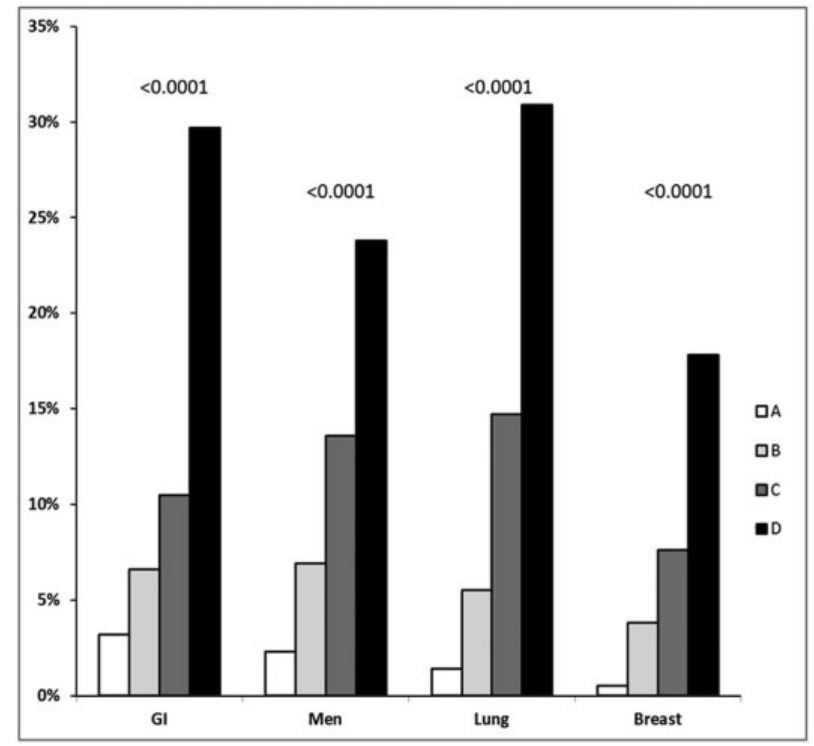
Fig. 4 Early mortality by groups at risk in the validation cohort of patients with cancer-associated thrombosis. ( A ) No metastatic disease and no elevated WBC count. ( B ) Metastatic disease without PE, immobility, elevated WBC count. ( C ) Metastasis and PE without elevated WBC count or immobility. ( D ) Elevated WBC count or metastatic disease with immobility in patients without elevated WBC count. GI, gastrointestinal. TH Open Vol. 2 No.